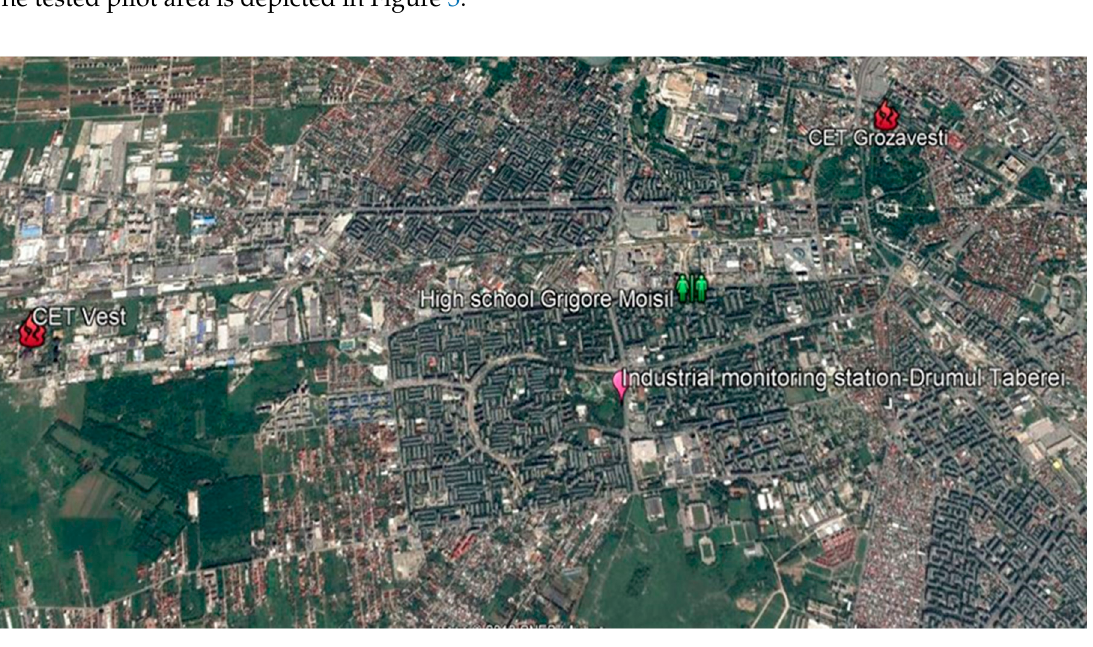
Figure 3. Developed solution pilot area .